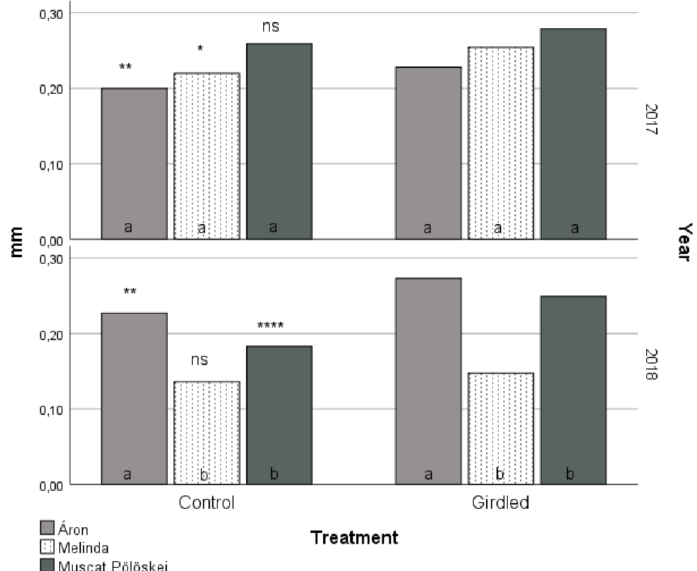
Figure 2. Results of the berry skin thickness test in the experimental years (2017, 2018). ( n = 50), * above the columns indicates a significant difference between the treatments in each cultivar; * p ≤ 0.05, ** p < 0.01 and **** p < 0.0001, ns = not significant. Different letters within the columns indicate significant differences ( p < 0.05) between the vintages for each cultivar.